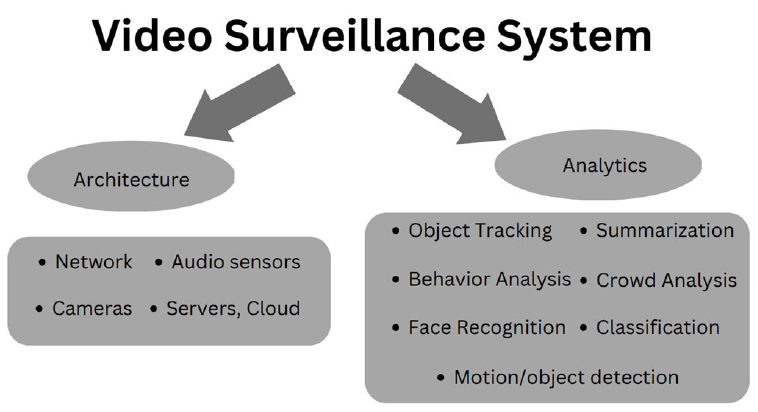
Figure 5. The component and functionality of VSS.